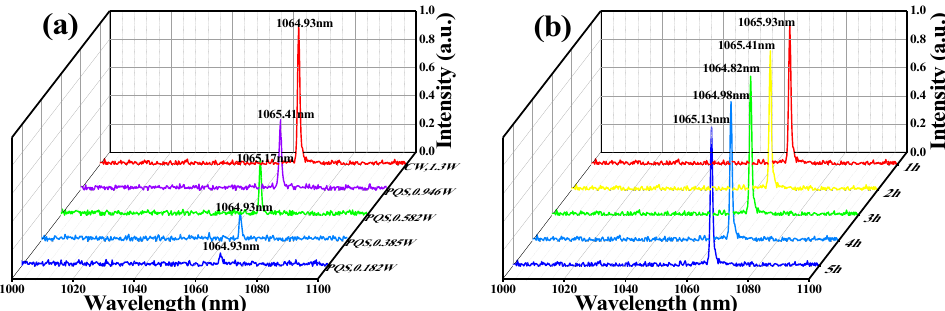
Figure 6. ( a ) Output spectrums of the Nd:YAG CW and PQS laser. ( b ) Output spectrums of the Nd:YAG PQS laser lasted for 5 h at the output power of 0.946 W. One InAsSb (DET10A/M, Thorlabs, Inc., Newton, NJ, USA) photodetector was used to collect the laser output pulse train signal, and a high-speed oscilloscope (DPO4104B, Tektronix, Inc., Shawnee Mission, KS, USA) with a bandwidth of 1 GHz and a sampling rate of 5 GHz is used for display measurement. By inserting the Ti 2 CT x -SAs in the cavity and gradually increasing the pump power, the pulse changed from a disordered waveform to a stable Q-switched sequence waveform. Figure 7b shows the pulse duration and repetition rate versus pump power. The pulse duration decreased from 600 ns to 163 ns with the increase of pump power, while the pulse repetition rate increased from 126.5 kHz to 260 kHz. At the pump power of 4.5 W, the shortest pulse duration of 163 ns was